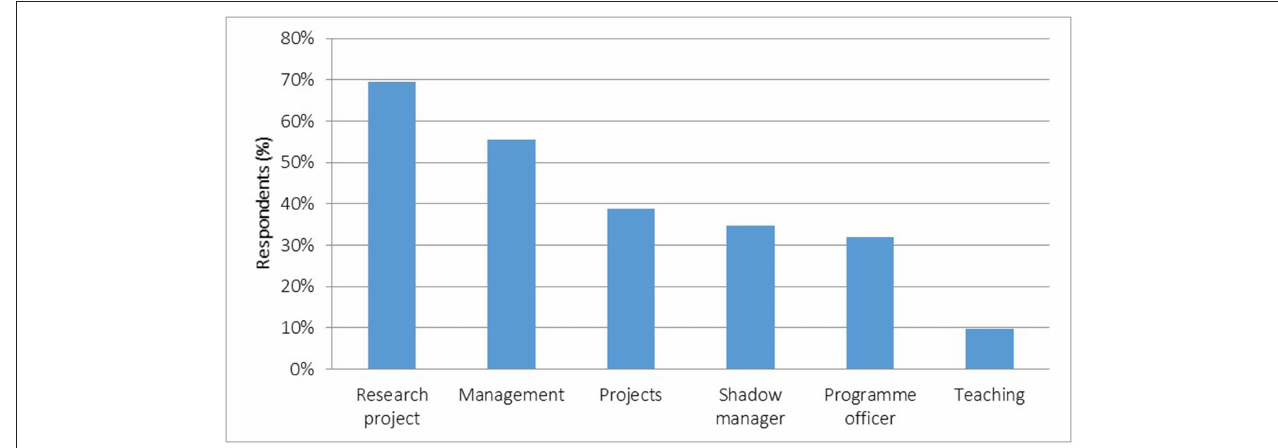
FIGURE 3 | Work performed in training rotations ( n =